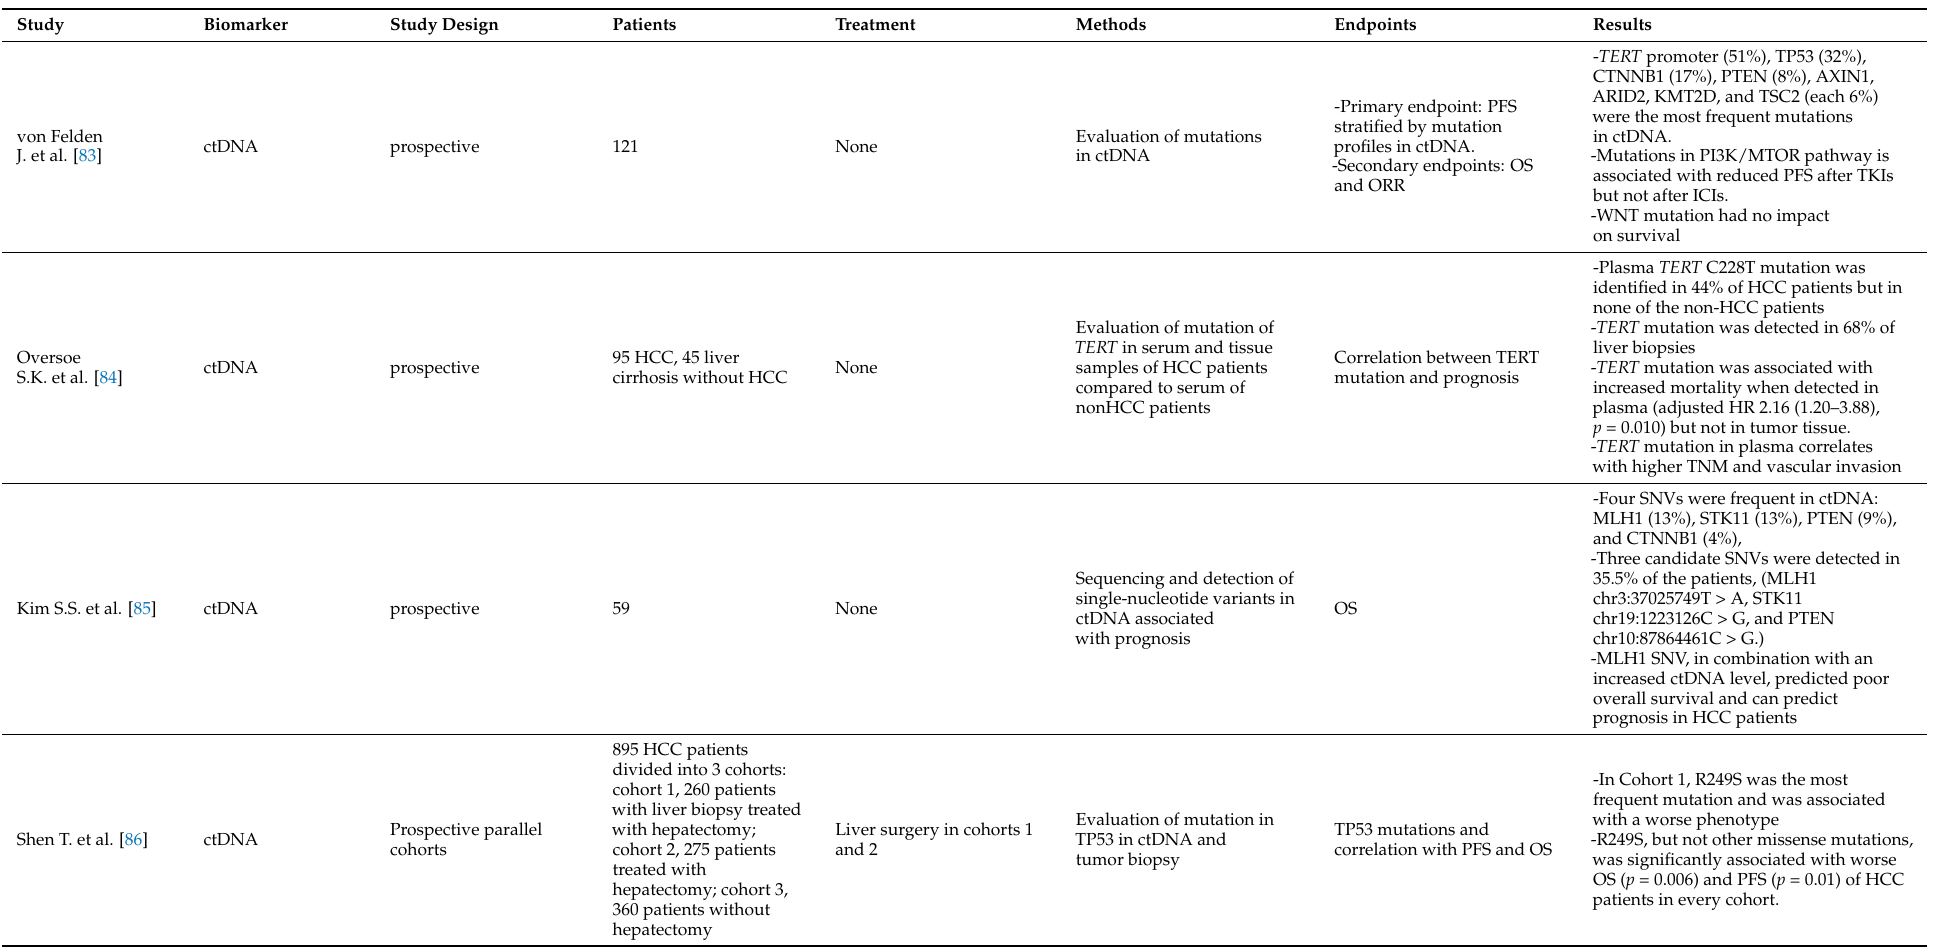
Table 2. Novel non-invasive biomarkers for immunotherapy in patients with hepatocellular carcinoma